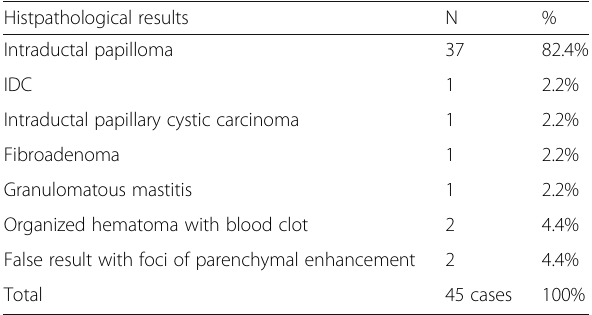
Table 2 represented the histopathological results of our patients